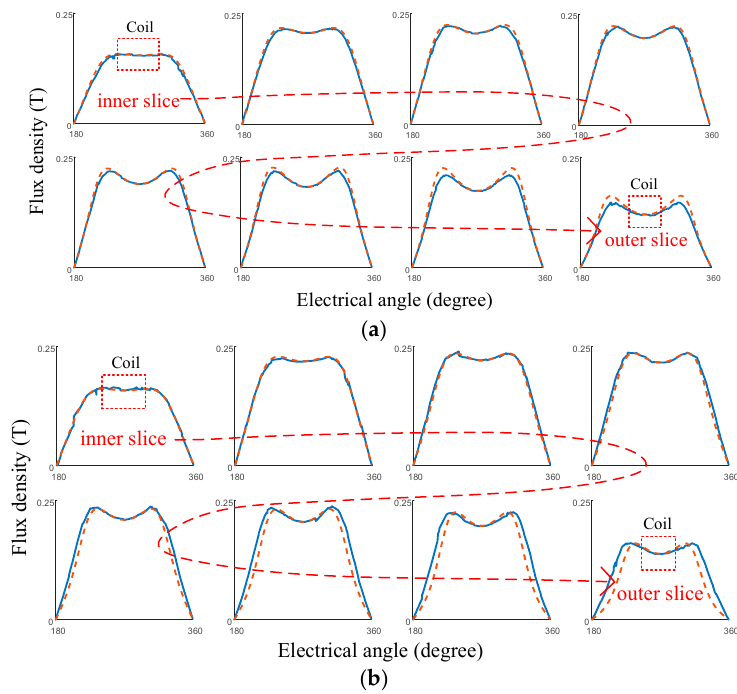
Figure 9. Flux intensity calculated with quasi-3-D and correction functions: ( a ) Conventional Halbach array; ( b ) VPAR-DHA. (Dotted lines and solid lines represent the results of the analytical method and 3-D FEM, respectively).